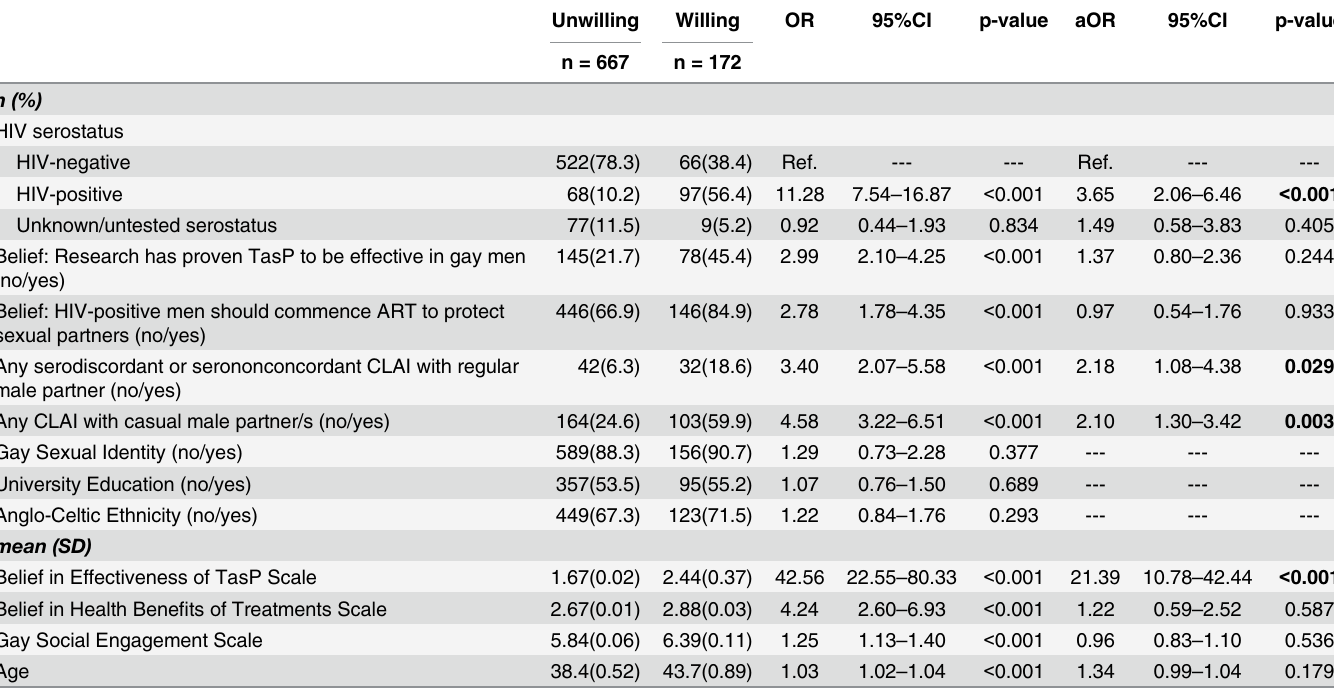
Table 3. Factors associated with willingness to have serodiscordant CLAI if the positive partner is taking ART (bivariate and